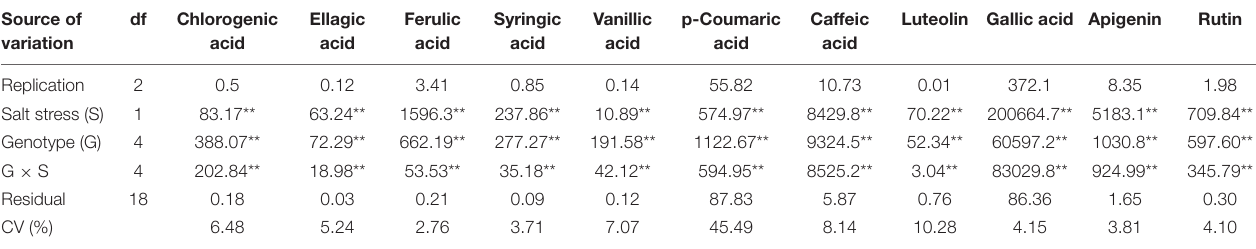
TABLE 3 | Analysis of variance of phenolic acids and flavonoids of the genotypes studied under control and salt stress conditions. Source of df variation